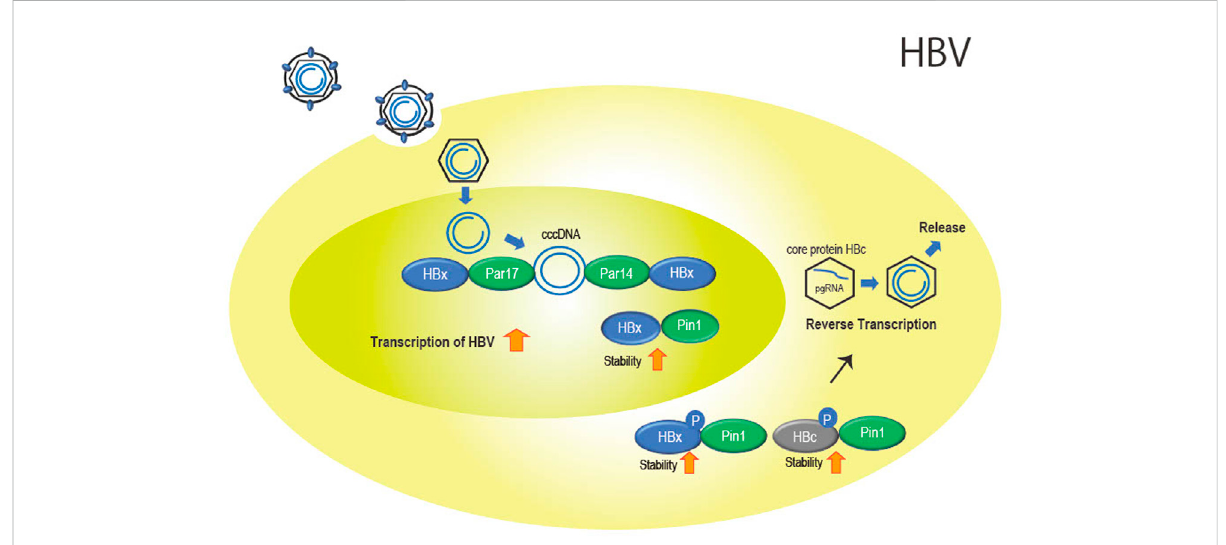
FIGURE 2 Role of the parvulin family in HBV infection. Par14 and Par17 bind to both cccDNA and HBx in the nucleus. This is thought to promote cccDNA replication and transcription of viral genes with stabilized HBx with Pin1 binding. In the cytoplasm, Pin1 also binds to HBx and HBc to promote nucleocapsid formation and reverse transcription as well as particle